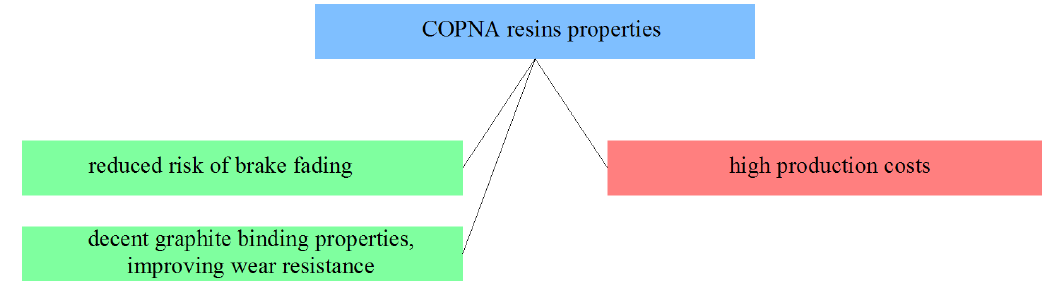
Figure 6: Selected COPNA resins properties from the point of view of applicability in friction materials